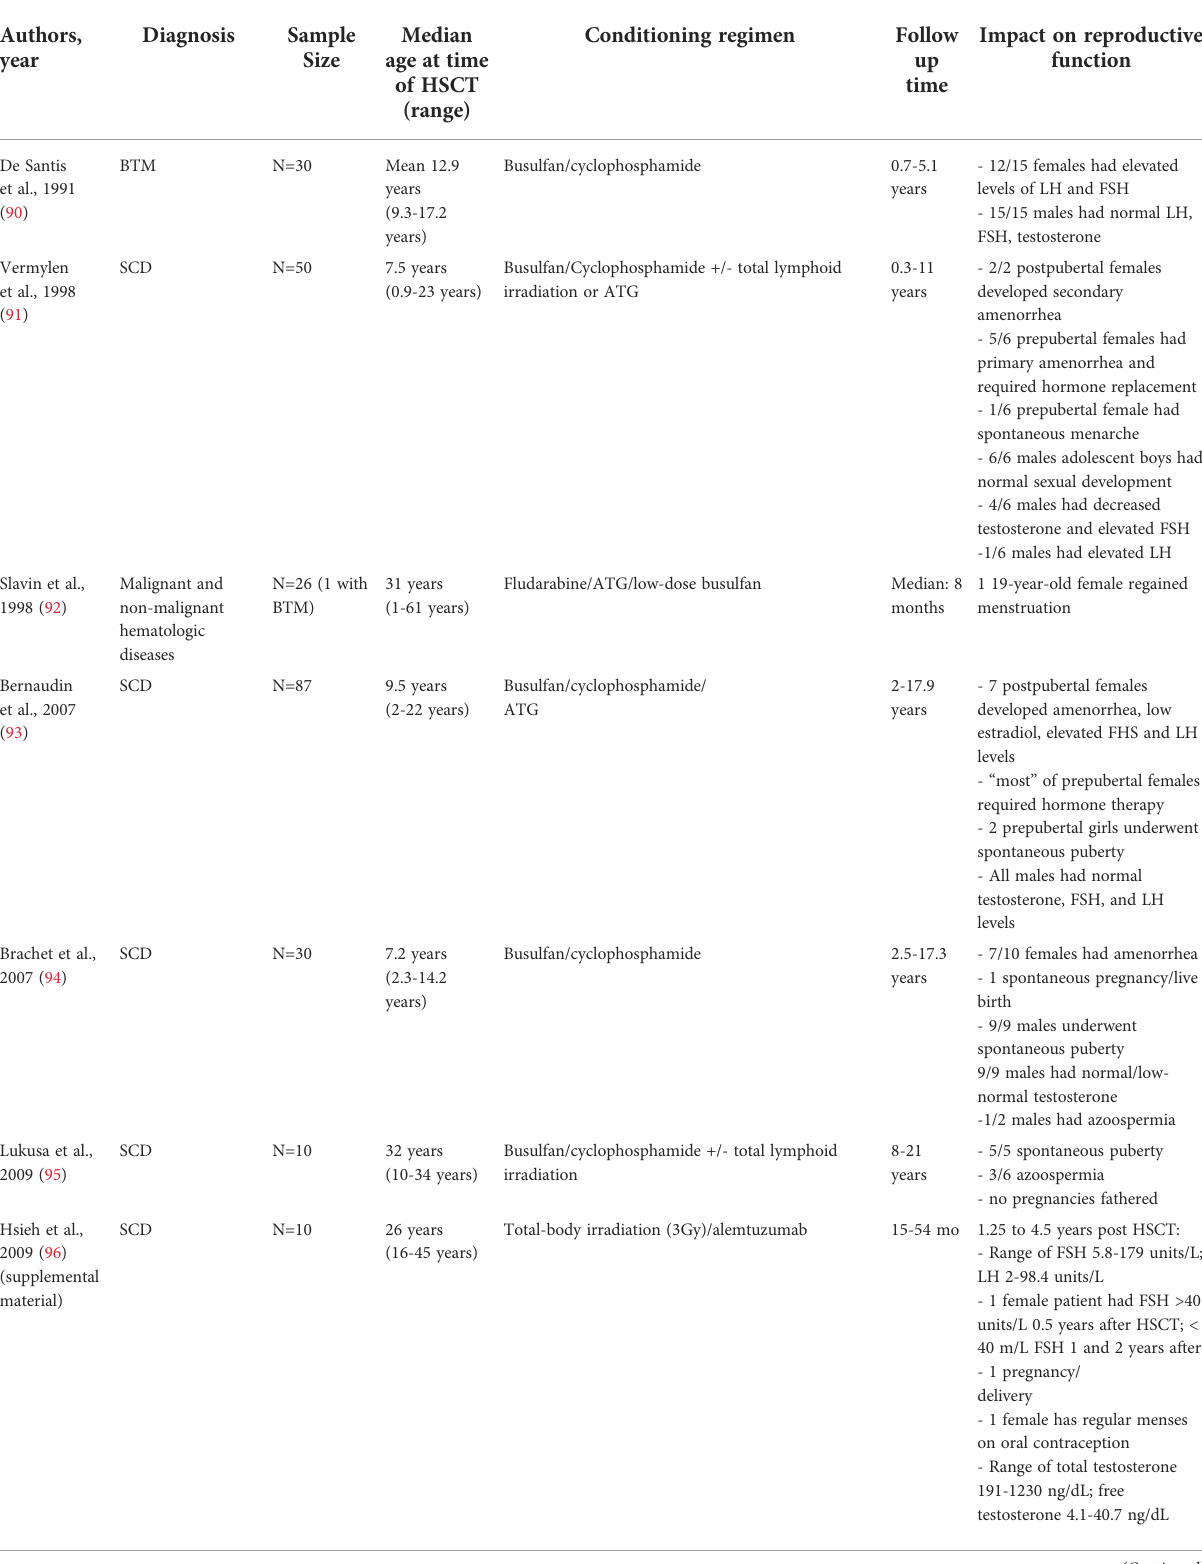
TABLE 2 Clinical studies of hematopoietic stem cell transplant in patients with sickle cell disease and beta thalassemia that evaluated reproductive